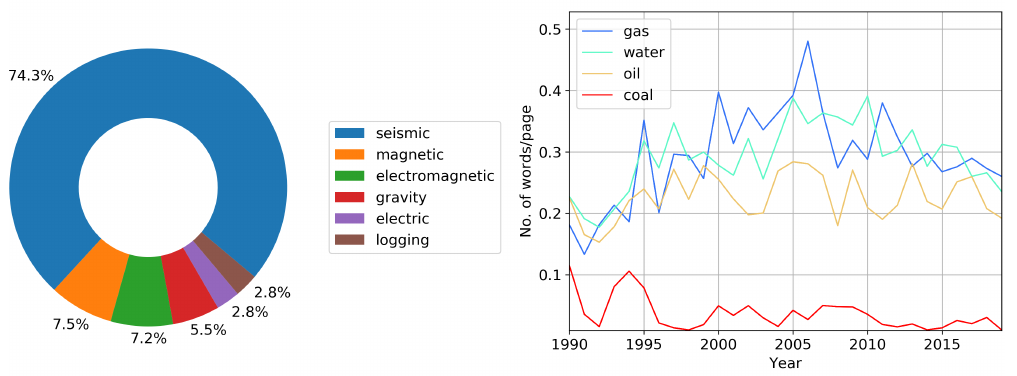
Figure 4. Geophysical methods of survey ( left ) and the most frequently used names of natural resources ( right